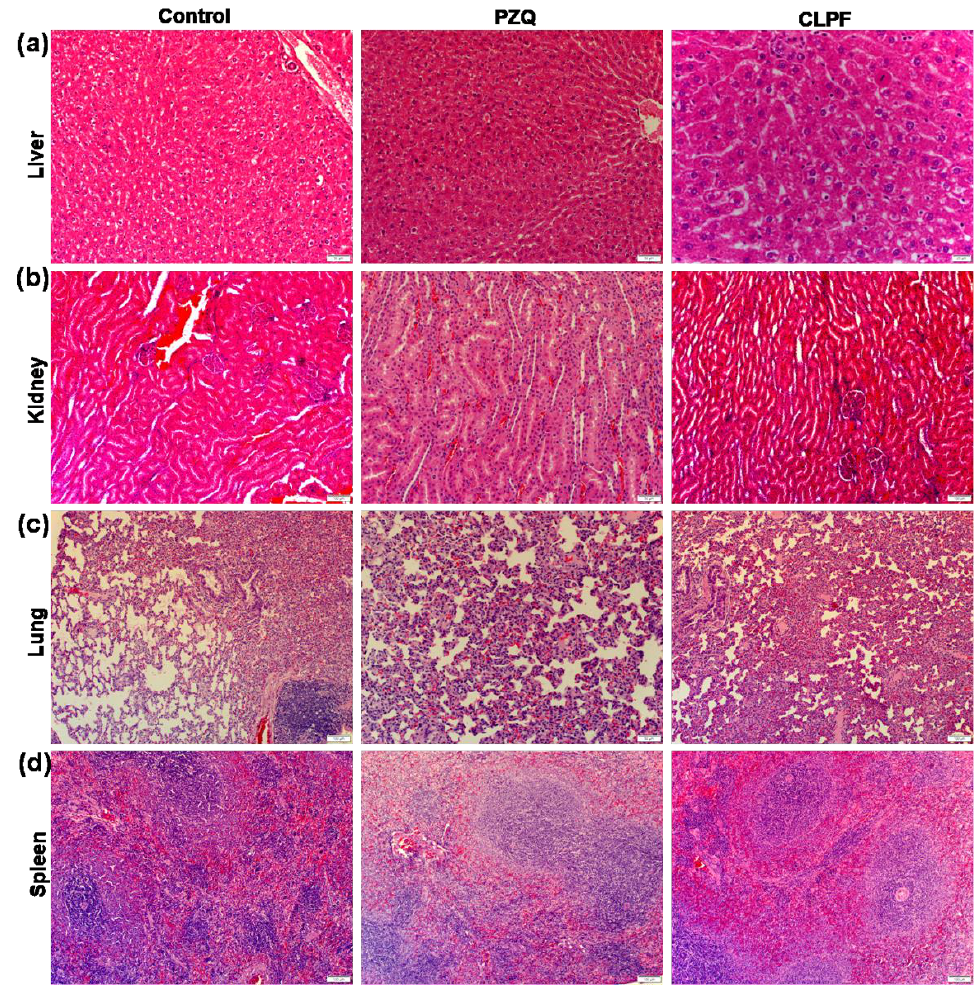
Figure 15. Histopathological images of ( a ) liver, ( b ) kidney, ( c ) lung, and ( d ) spleen after treating uninfected rats with 250 mg/kg of PZQ and CLPF (×20 magnification). CLPF: PZQ-loaded Compritol-lecithin-solid lipid nanoparticles with PF127; PZQ: Praziquantel.